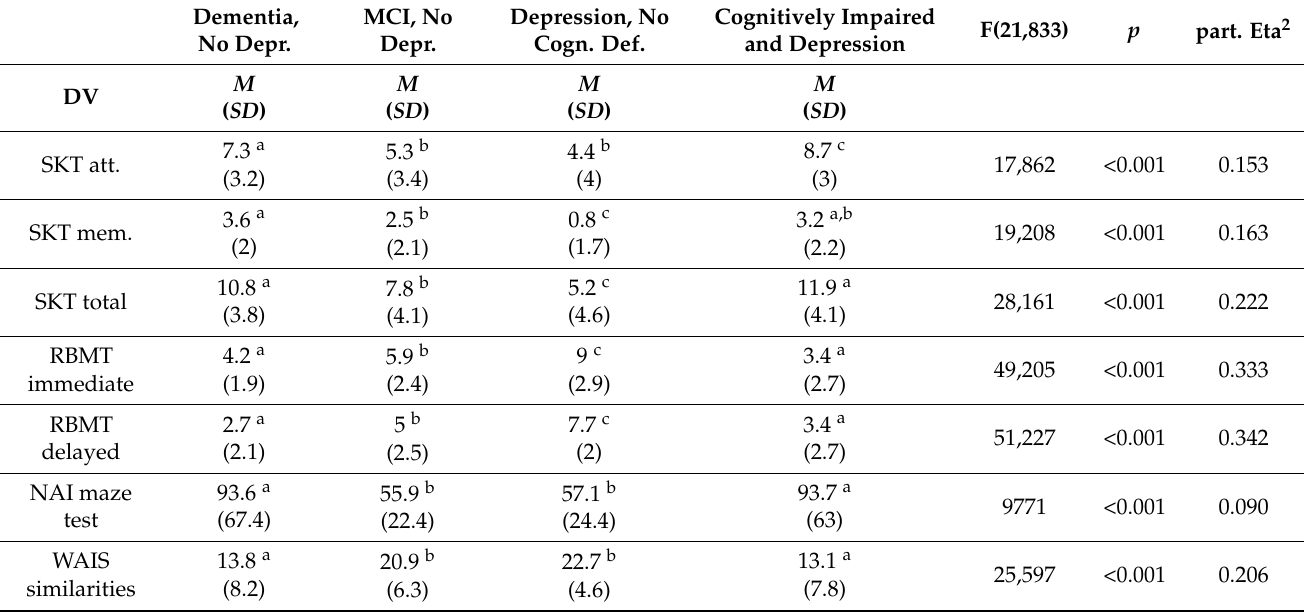
Table 4. Results of MANOVA with respect to NPE ( n = 300).